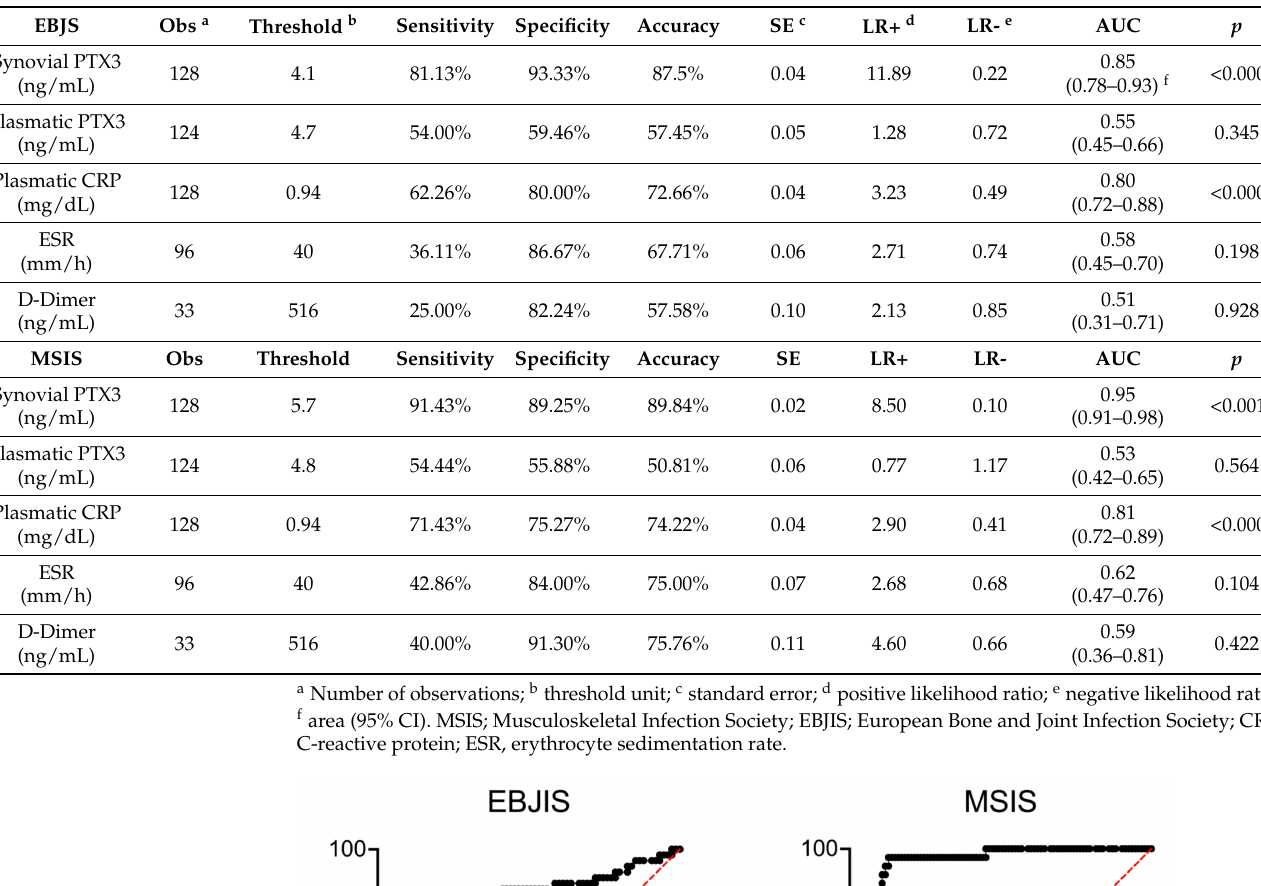
Table 5. ROC curve analysis of synovial and plasmatic biomarkers.